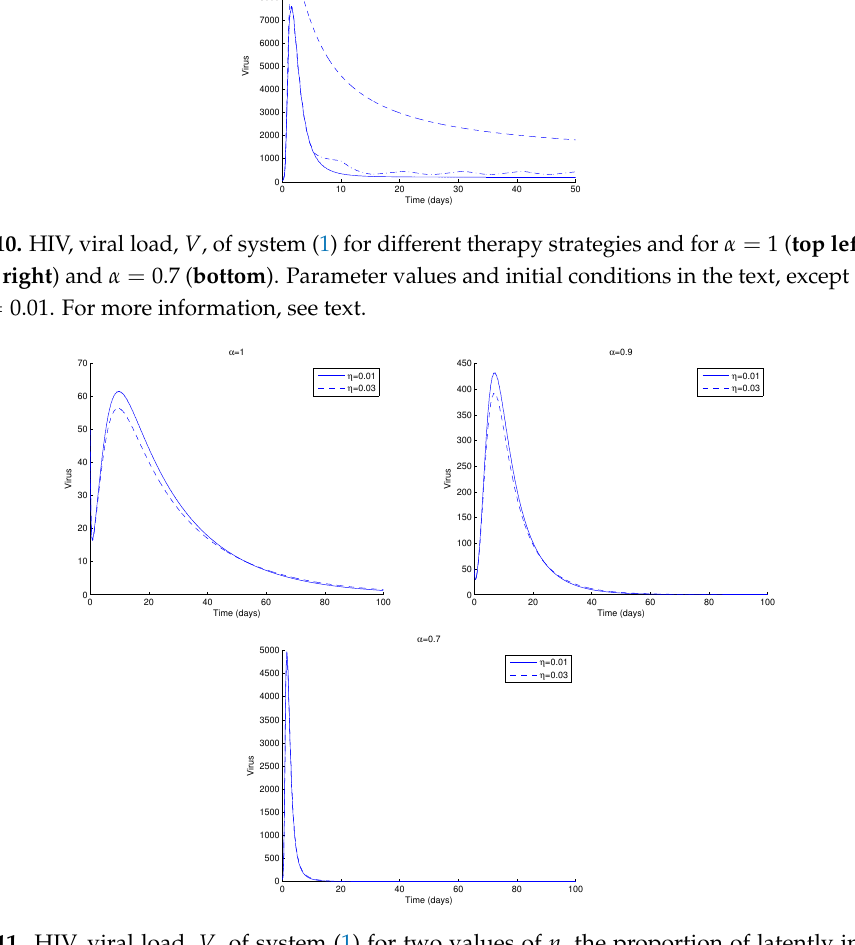
Figure 11. HIV, viral load, V , of system (1) for two values of η , the proportion of latently infected cells, and for α = 1 ( top left ), α = 0.9 ( top right ) and α = 0.7 ( bottom ). Parameter values and initial conditions in the text, except for R k = 2.5. For more information, see